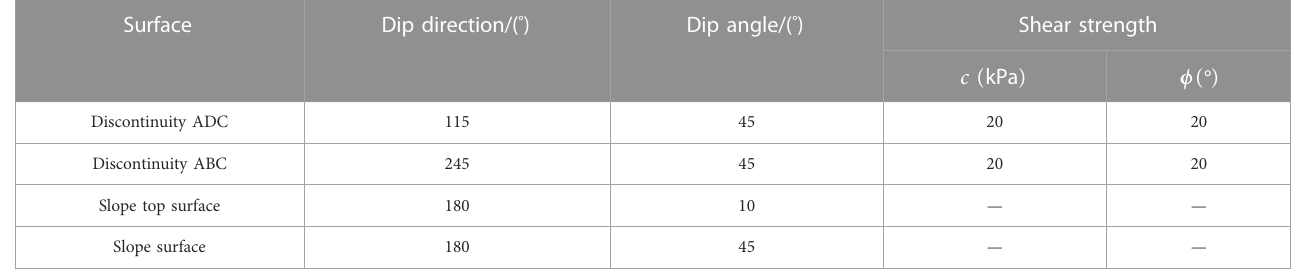
TABLE 1 Geometrical and material parameters of example 1.